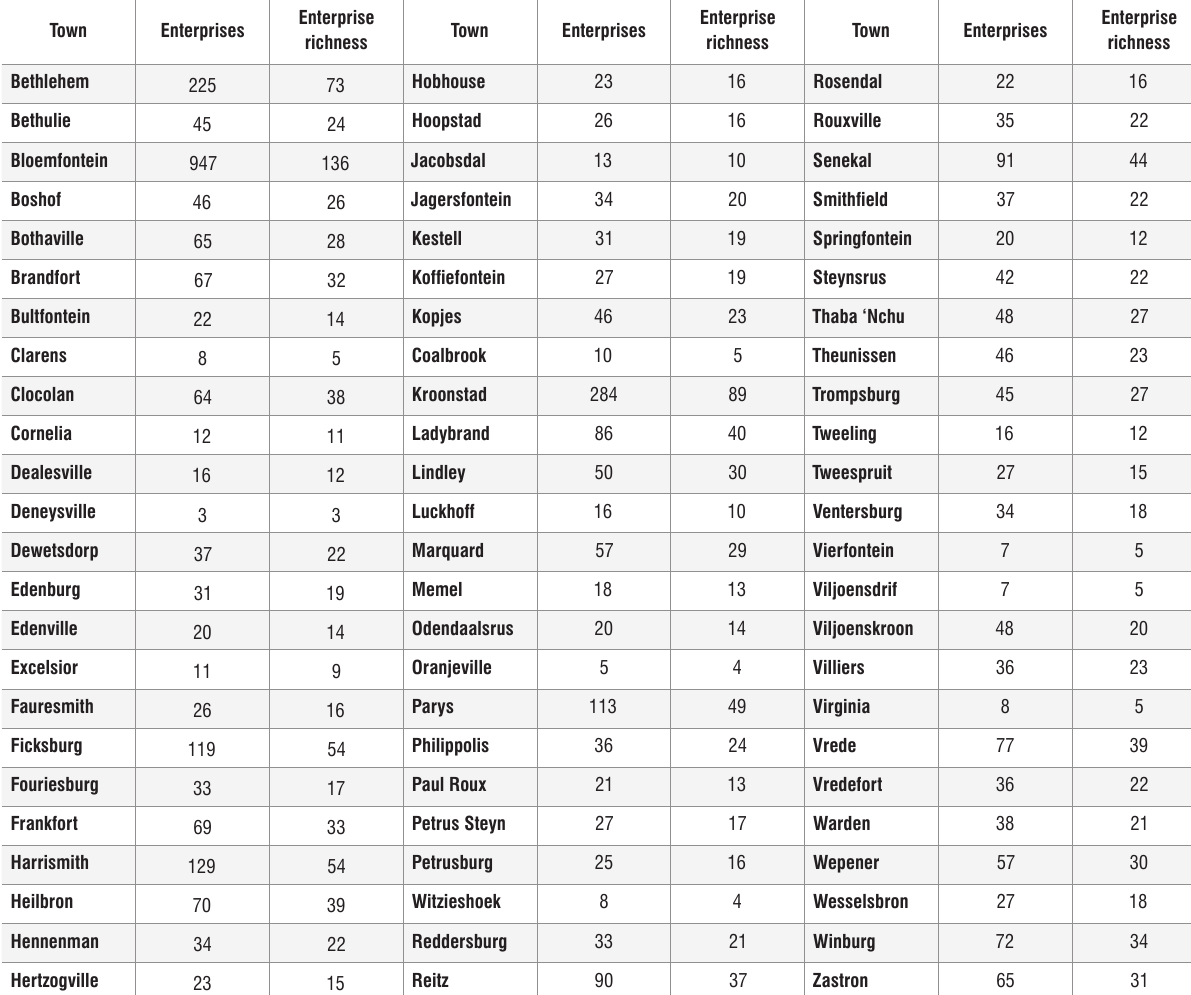
Total number of enterprises and enterprise types (enterprise richness) in Free State towns (towns and villages) in